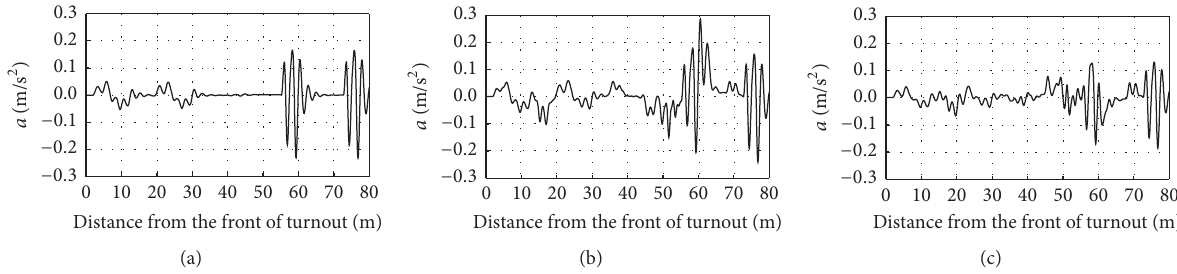
Figure 9: Vertical acceleration of the vehicle body ((a) track stiffness neglected; (b) original track stiffness; (c) optimised track stiffness).